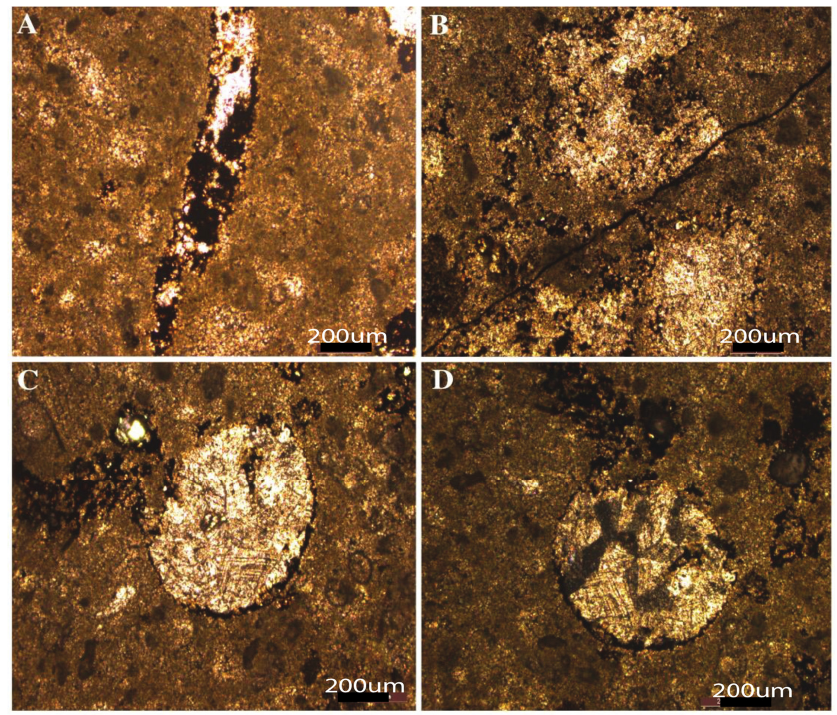
Figure 6. Photomicrographs ( A , B ) showing the dolomite crystals inside the fracture ( A ) and pore spaces filled by organic matter ( B ). ( C , D ) Voids filled by coarse crystalline saddle dolomite crystals under PPL ( C ) and XPL ( D ). The dark spots and the outline of the voids are represented by the hydrocarbon accumulation. Geometrically, these photomicrographs ( A – D ) show that the hydrocar- bon migration (see the black colored material) is always associated with dolomite formation, both early and late dolomite crystals.